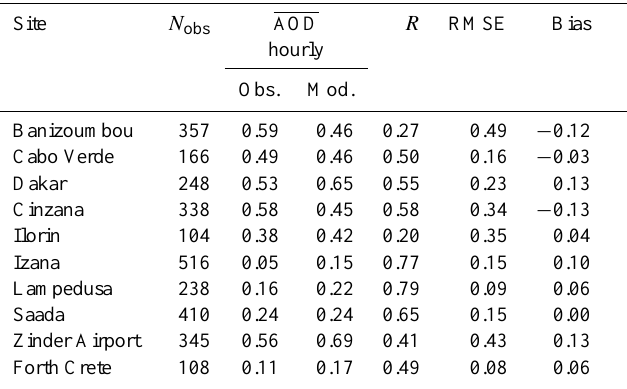
Table 8. R , RMSE and bias of measured and modeled hourly AOD, for AERONET